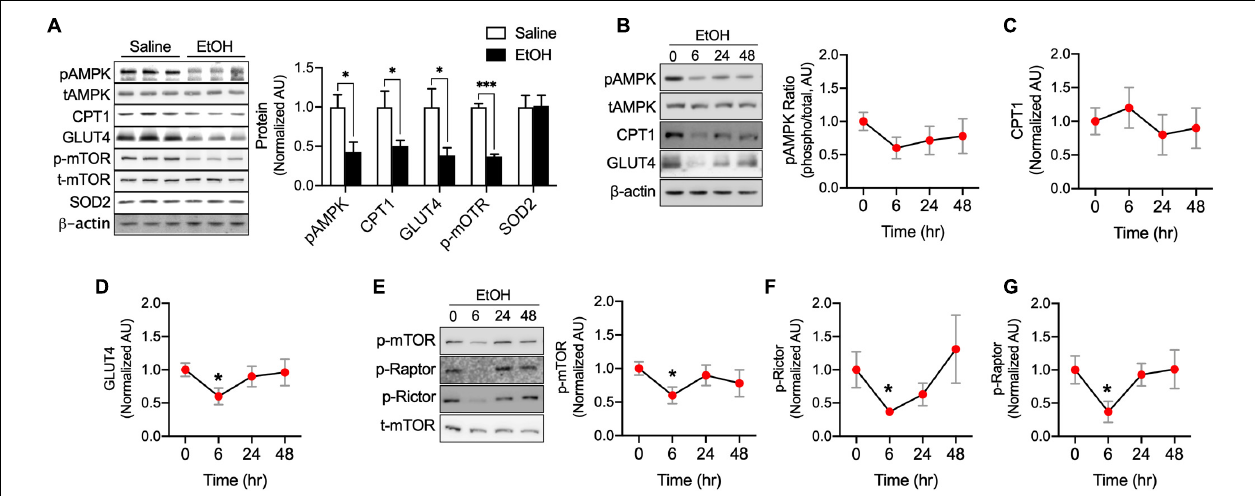
FIGURE 2 | EtOH directly downregulated pAMPK, CPT1, GLUT4, and p-mTOR content in myotubes. (A) Protein content of the key metabolic factors, AMPK, CPT1, GLUT4, and mTOR, and of the antioxidant SOD2 was measured in myotubes exposed to 50 mM EtOH for 24 h ( n = 6 myotubes/group). Values are means ± SE. * P < 0.05 versus non-treated controls. Significance was determined using the student’s t -test. (B–G) Protein content of AMPK, CPT1, GLUT4, mTOR, Raptor, and Rictor in myotubes was measured after exposure to 30 mM EtOH for different times ( n = 6 myotubes/time point). Values are means ± SE. * P < 0.05 and *** p < 0.001 versus baseline. Significance was determined using one-way